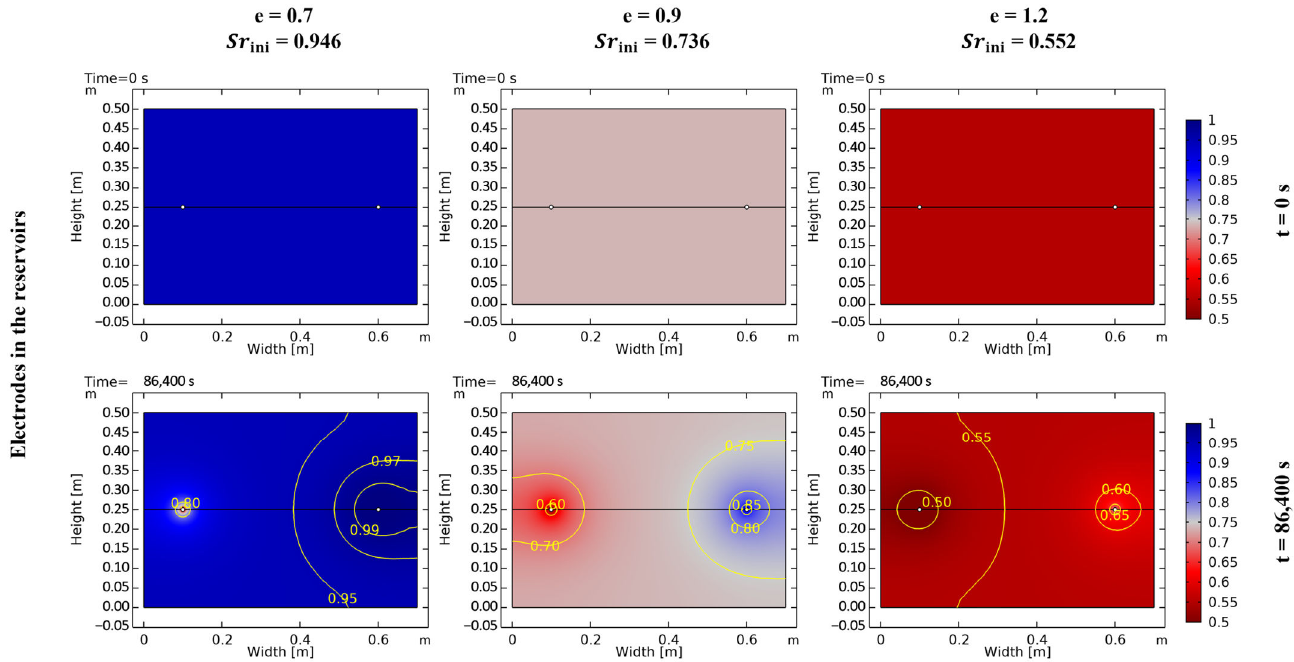
Figure 5. 2D maps of the degree of saturation evaluated at two times, 0 and 86,400 s (1 d), and three void ratios, 0.7, 0.9, and 1.2, when the electrodes were inserted into the soil corresponding to the configuration presented in Figure 1b. An electric potential gradient of 1 Vcm − 1 was